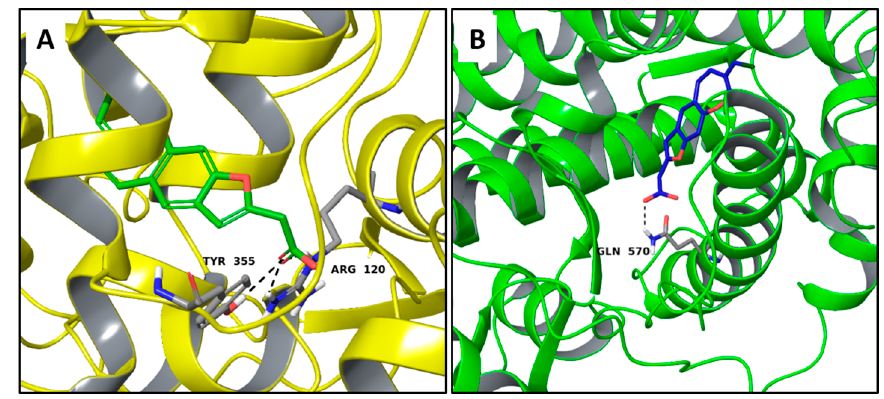
Figure 6. Molecular interactions of pterulinic Acid and two anti-inflammatory targets: ( A ) Protein target, COX-1 (PDB: 1Q4G). Protein is shown as a yellow cartoon while ligand is shown as green carbon sticks; ( B ) Protein target: glucocorticoid receptor (PDB: 1M2Z). Protein is shown as a florescent green cartoon while ligand is shown as dark blue carbon sticks. H-bonds and π - π interactions are shown as dashed black and cyan lines respectively. Amino acid residues involved in the interactions are shown as gray sticks.